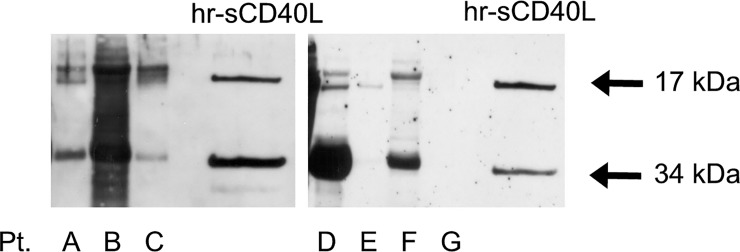
Detection of sCD40L in plasma fractions obtained by plasmapheresis eluates of FSGS patients by Western blotting.Western blot analysis of sCD40L in PF preparations obtained from plasmapheresis eluates of different FSGS patients with elevated Palb (lanes A-F), and from a normal patient with negative Palb (lane G). In the former case, PF was prepared utilizing plasma from FSGS patients undergoing plasmapheresis and separated on Protein A at different conditions; in the second case, normal plasma without Palb activity was obtained as unbound to Protein A material. PF preparations (5μg) were immunoblotted with anti-sCD40L antibody, which identified two bands, at 17 and 34 kDa, corresponding to the monomeric and dimeric forms of the molecule, respectively. hr-sCD40L (500 ng) was used as positive control. Each lane corresponds to an individual patient.